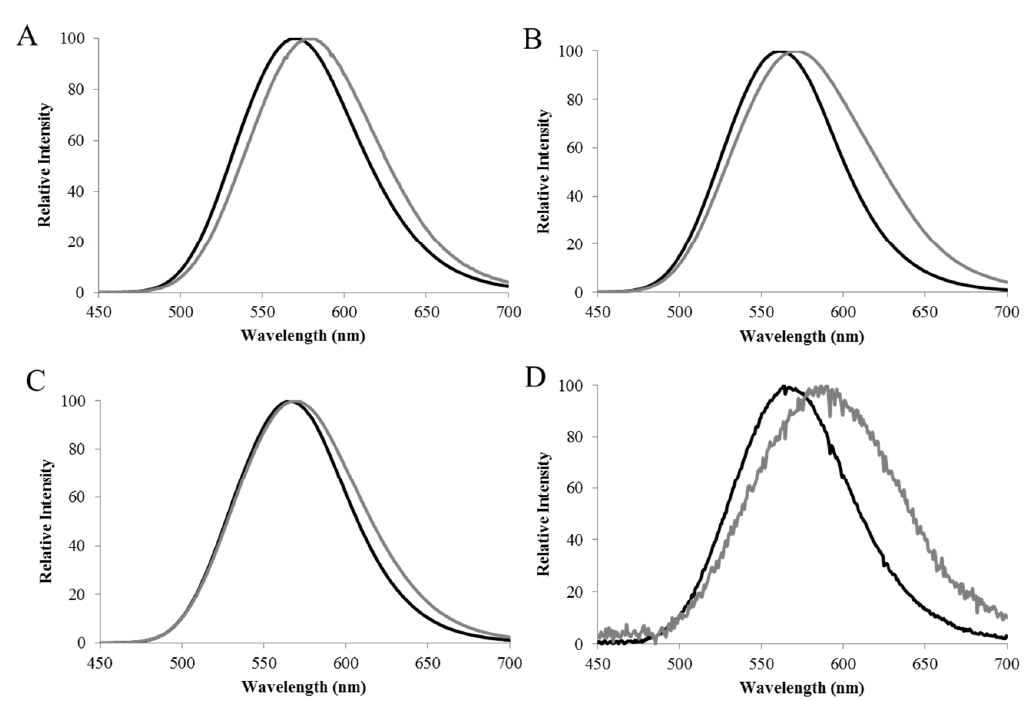
Figure 3. The residue E354 is important for luciferase sensitivity to Zinc. Effect of 2 mM zinc on the bioluminescence spectra of: ( A ) Macrolampis sp2 wild-type; ( B ) C. distinctus wild-type; ( C ) C. distinctus E354N, and ( D ) Macrolampis sp2 N354E mutant (black line) without zinc, and (gray lines) in the presence of zinc. Reprinted with permission from ref. [33]. Copyright 2016 Springer.